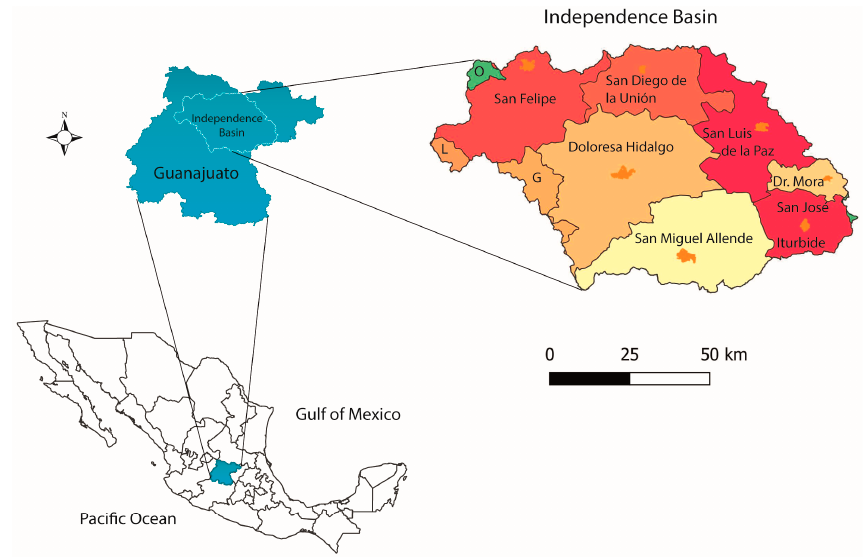
Figure 1. Location of the Independence Basin and its divide in the state of Guanajuato, central Mexico. The municipalities that comprise the IB are San Felipe, San Diego de la Unión, San Luis de la Paz, Dolores Hidalgo, San Miguel Allende, Dr. Mora, and San José Iturbide. Small fractions of the municipalities of Guanajuato (G), León (L) and Ocampo (O) also belong to the IB.